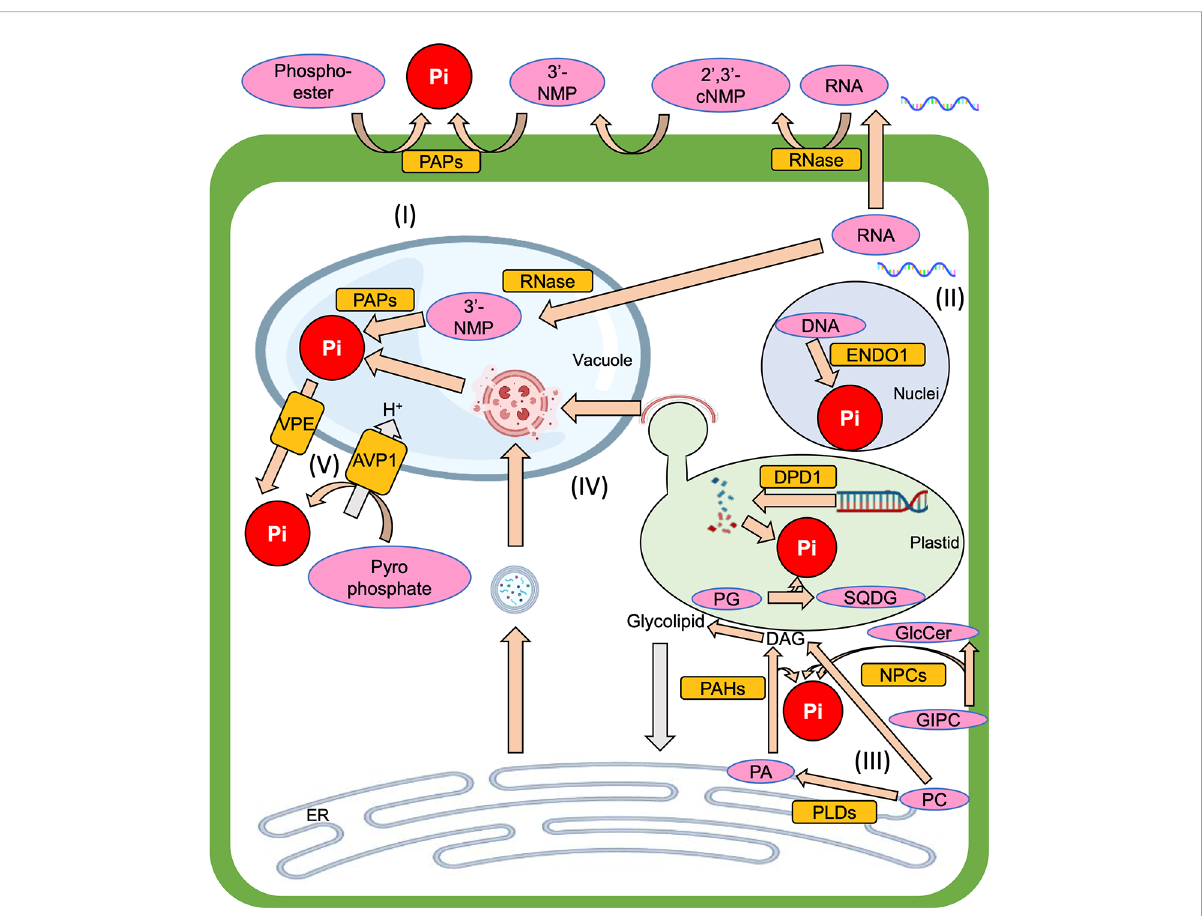
FIGURE 1 The overview of Pi recycling systems which are introduced in this mini-review, (I) Phosphoester degradation, (II) Nucleic acid degradation, (III) Membrane lipid remodeling, (IV) Autophagy, (V) Vacuolar transporter. Pi, inorganic phosphate; PAP, purple acid phosphatase; RNase, Ribonuclease; 2 ’ ,3 ’ -cNMP, 2 ’ ,3 ’ -cyclic nucleoside monophosphate intermediate; 3 ’ -NMP, 3 ’ -nucleoside monophosphate; ENDO1, endonuclease 1; DPD1, defective in pollen organelle DNA degradation 1; PG, phosphatidylglycerol; SQDG, sulfoquinovosyldiacylglycerol; GIPC, glycosylinositolphosphorylceramide; GlcCer, glucosylceramide; ER, endoplasmic reticulum; PC, phosphatidylcholine; PA, phosphatidic acid; DAG, diacylglycerol; PLC, phospholipase C; NPC, non-speci fi c PLC; PLD, phospholipase D; PAH, phosphatidic acid phosphohydrolase;